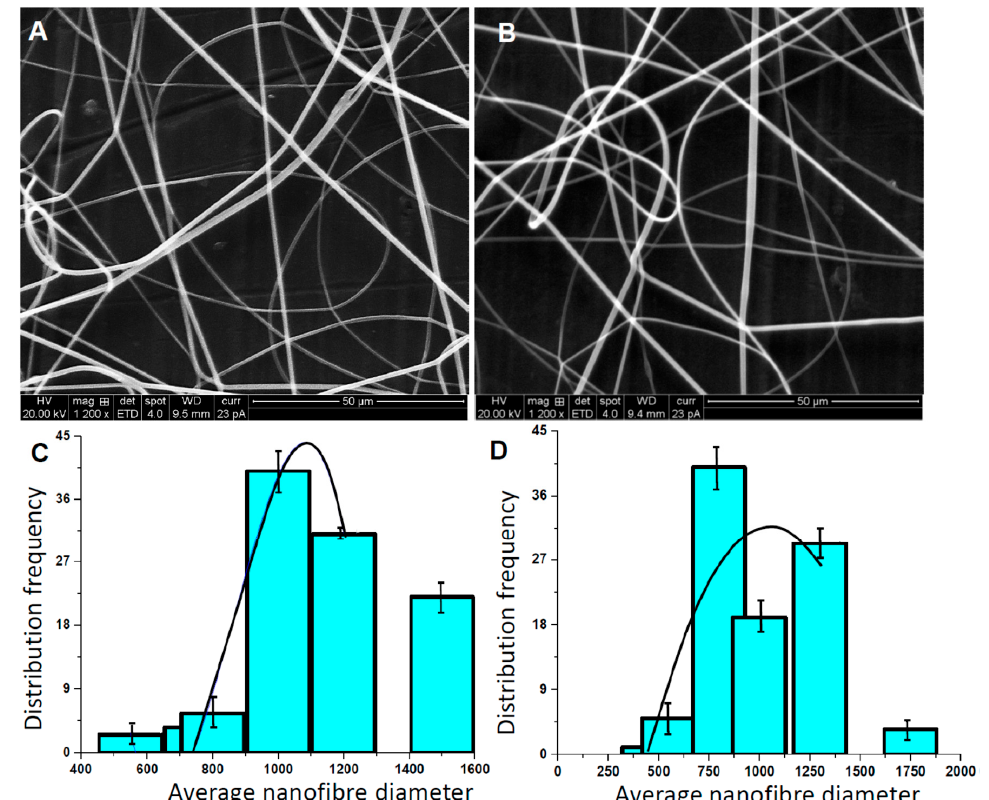
Figure 2. Physical Characterization. Scanning electron microscopy (SEM) micrographs of ( A ) / Gelatin 70:30 ( B ) PLGA / Gelatin 50:50 nanofibrous sca ff olds and ( C ) Average fiber size PLGA/Gelatin 70:30 ( B ) PLGA/Gelatin 50:50 nanofibrous scaffolds and ( C ) Average fiber size PLGA